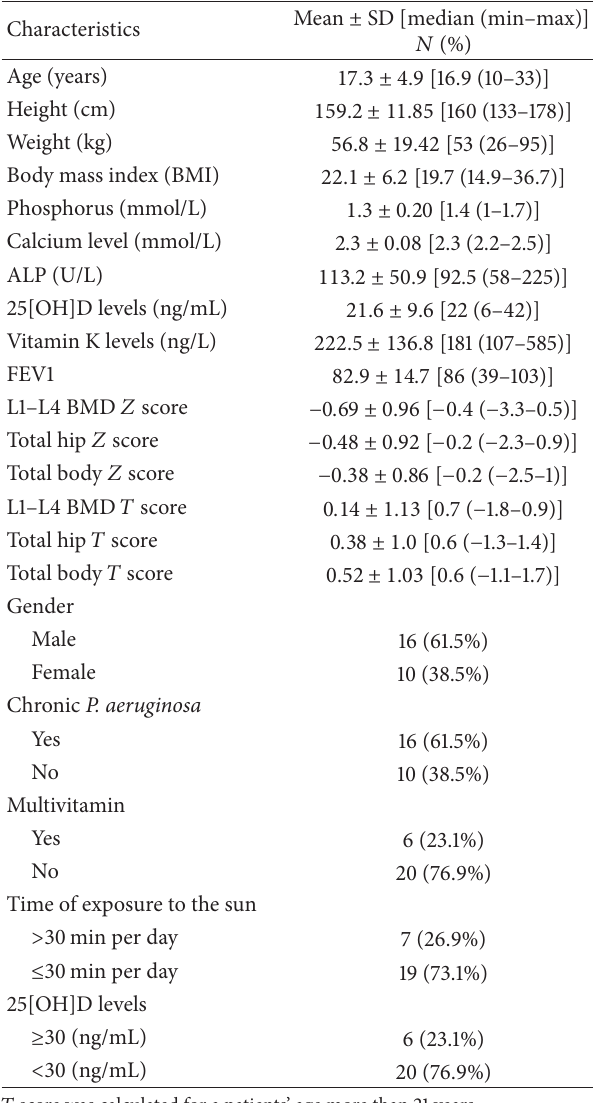
Table 1: Baseline demographic, anthropometric, nutritional, and other clinical